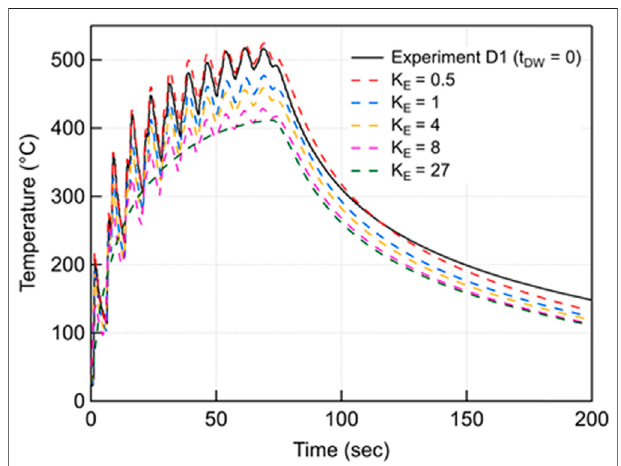
FIGURE 9 | Effect of K E (sub-track sizes) on temperature evolution at Thermocouple location in experiment Case D1.